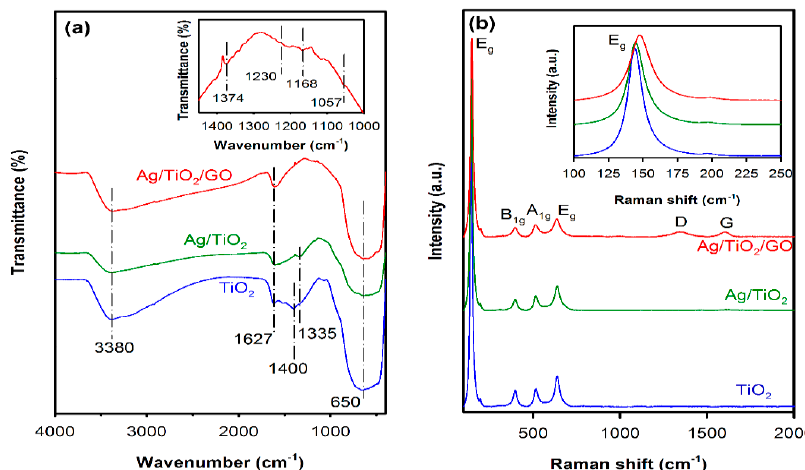
Figure 4. ( a ) FTIR and ( b ) Raman spectra of TiO 2 , Ag/TiO 2 , and Ag/TiO 2 /GO nanocomposites. Inset in ( a ) shows the magnified FTIR spectrum of Ag/TiO2/GO nanocomposites from 1000 to 1450 cm − 1